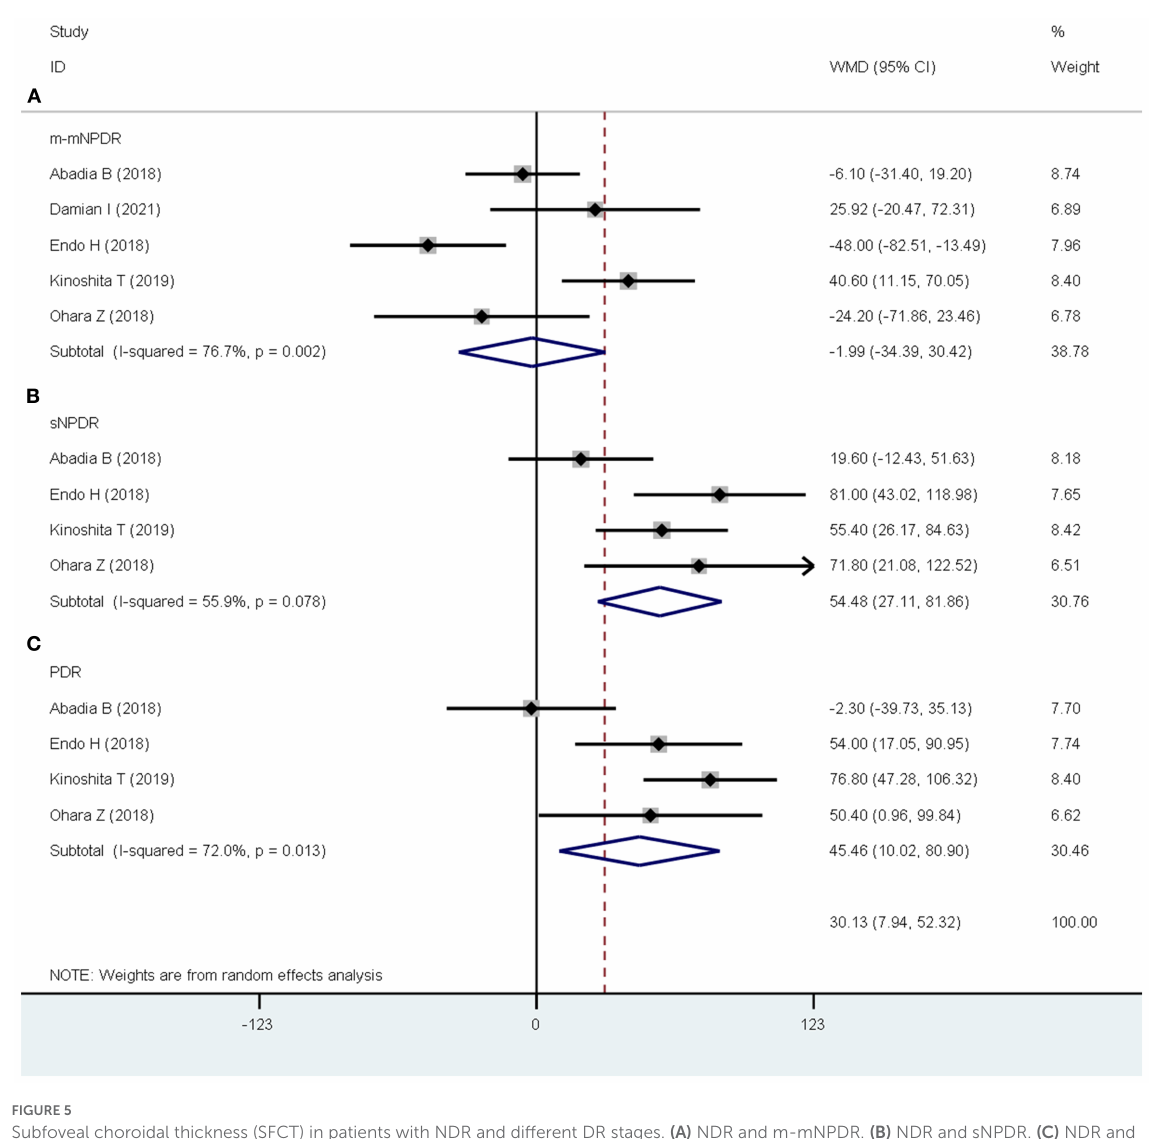
thickness (26, 28, 30) and CVI (5, 8, 23). To explore the choroidal structure changes in each DR stage, we pooled outcomes based on the different DR stages, including m- mNPDR (mild to moderate non-proliferative DR), sNPDR and PDR.